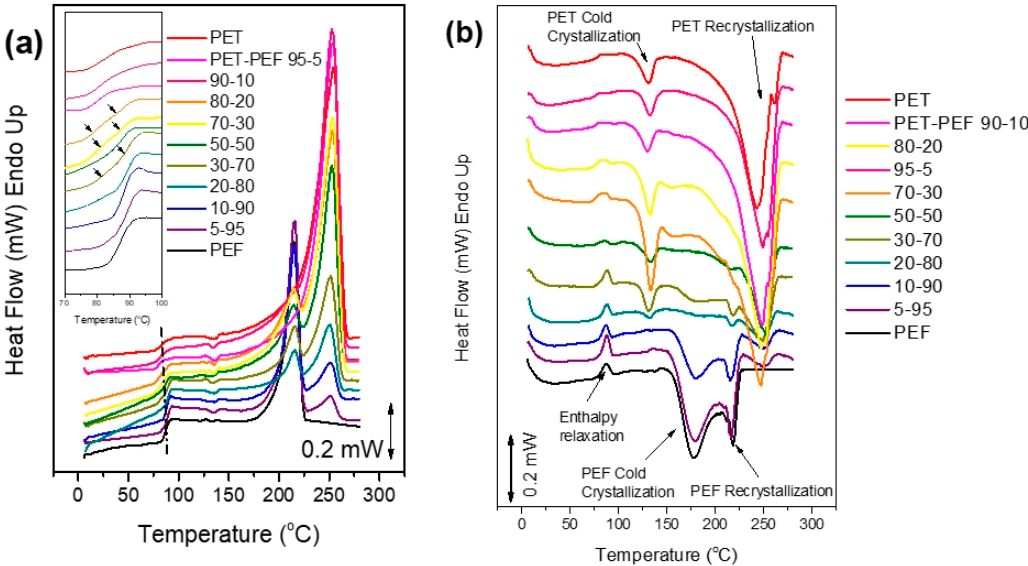
Figure 3. Modulated Temperature DSC (MDSC) thermograms for the fast-cooled upon heating at 5 ◦ C/min: ( a ) reversing signals and ( b ) non-reversing